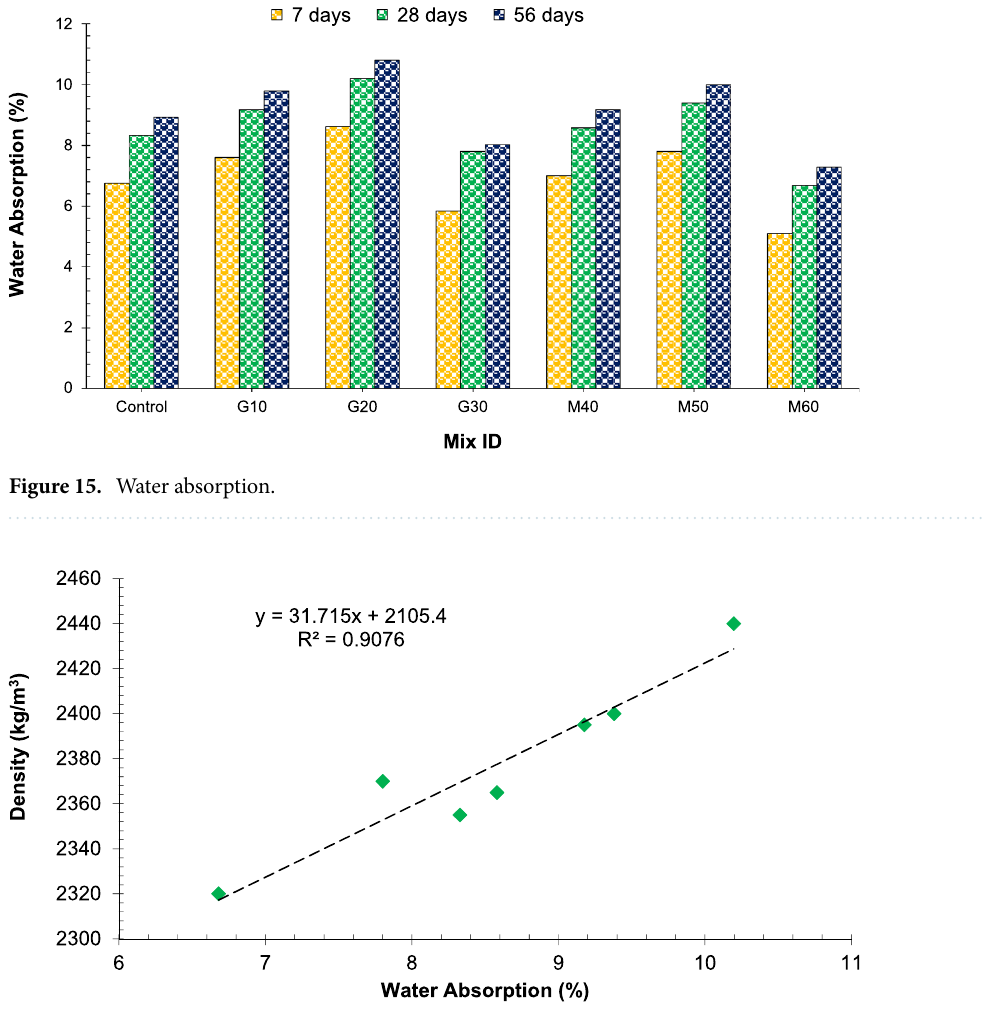
Figure 16. Correlation between density and water